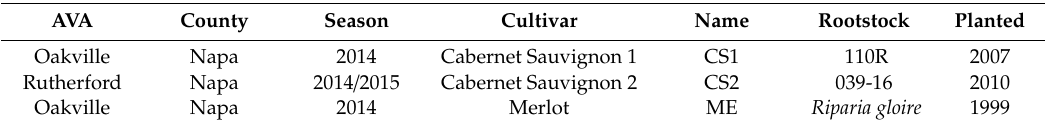
Table 7. American Viticultural Area (AVA), county, season, cultivar, rootstocks, and age of the vineyards used for the